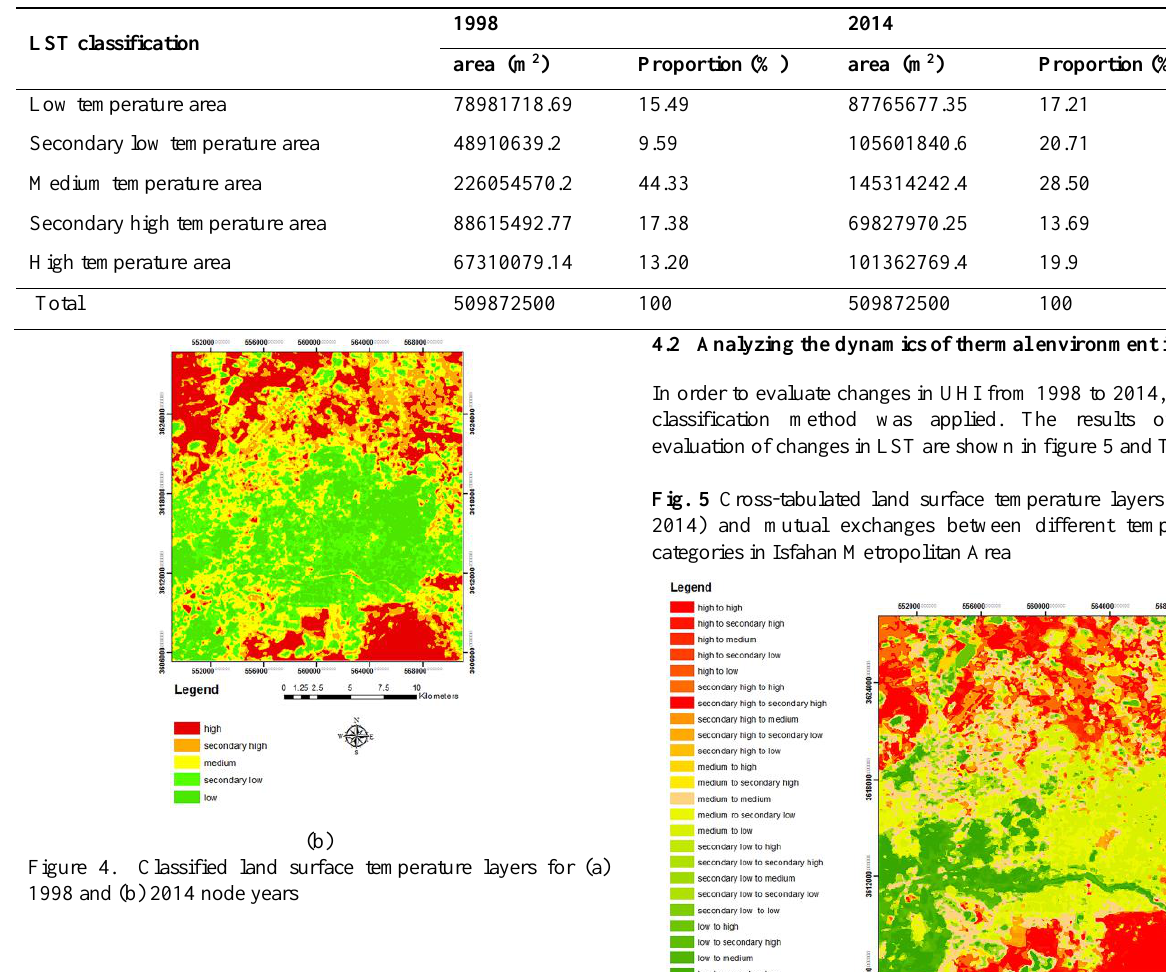
Table 3 Area of each land surface temperature category in 1998 and 2014 node